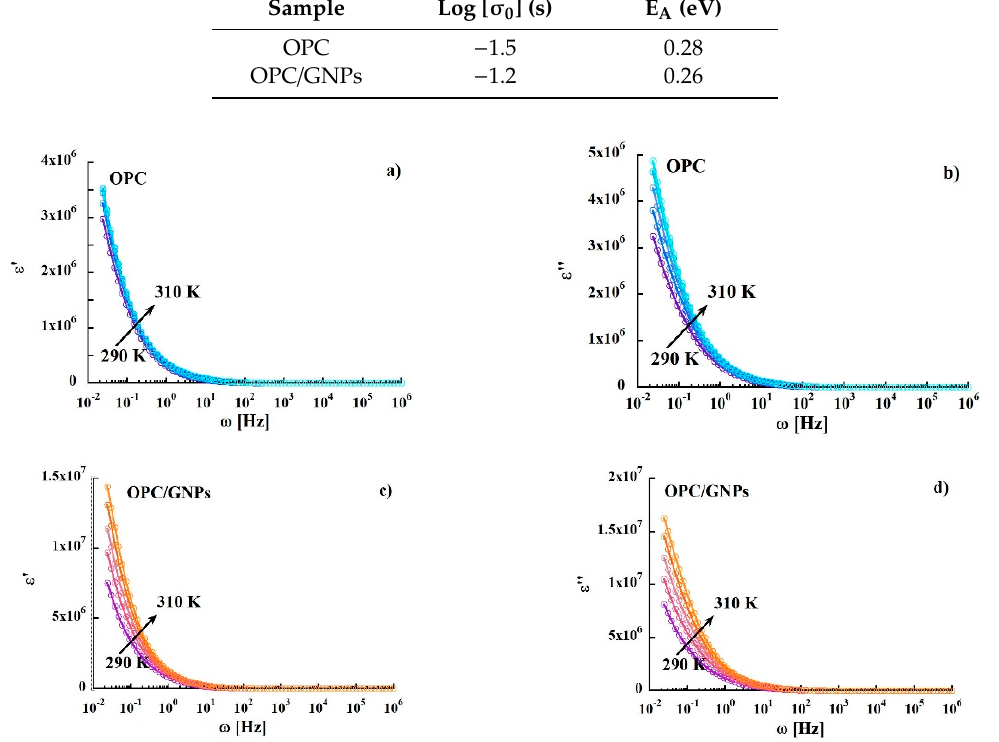
Figure 6. Frequency dependence of real and imaginary part of permittivity in OPC, ( a , b ), and in OPC/GNPs, ( c , d ), in the temperature range 290–310 K. Table 3. Activation Energy ( E A ) and pre-Exponential Factor (log [ σ 0 ]), which were obtained from the Arrhenius equation.